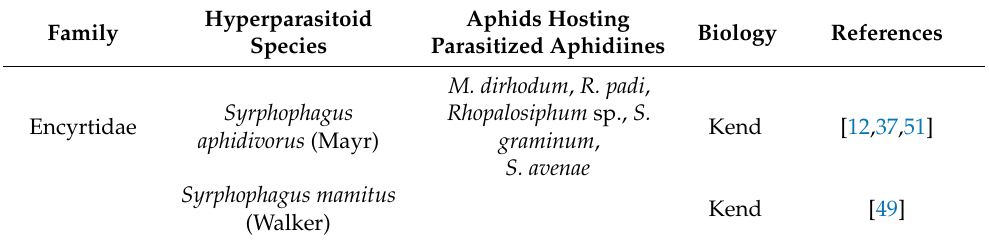
Table 2. Literature review of hyperparasitoids of cereal aphid parasitoid in European